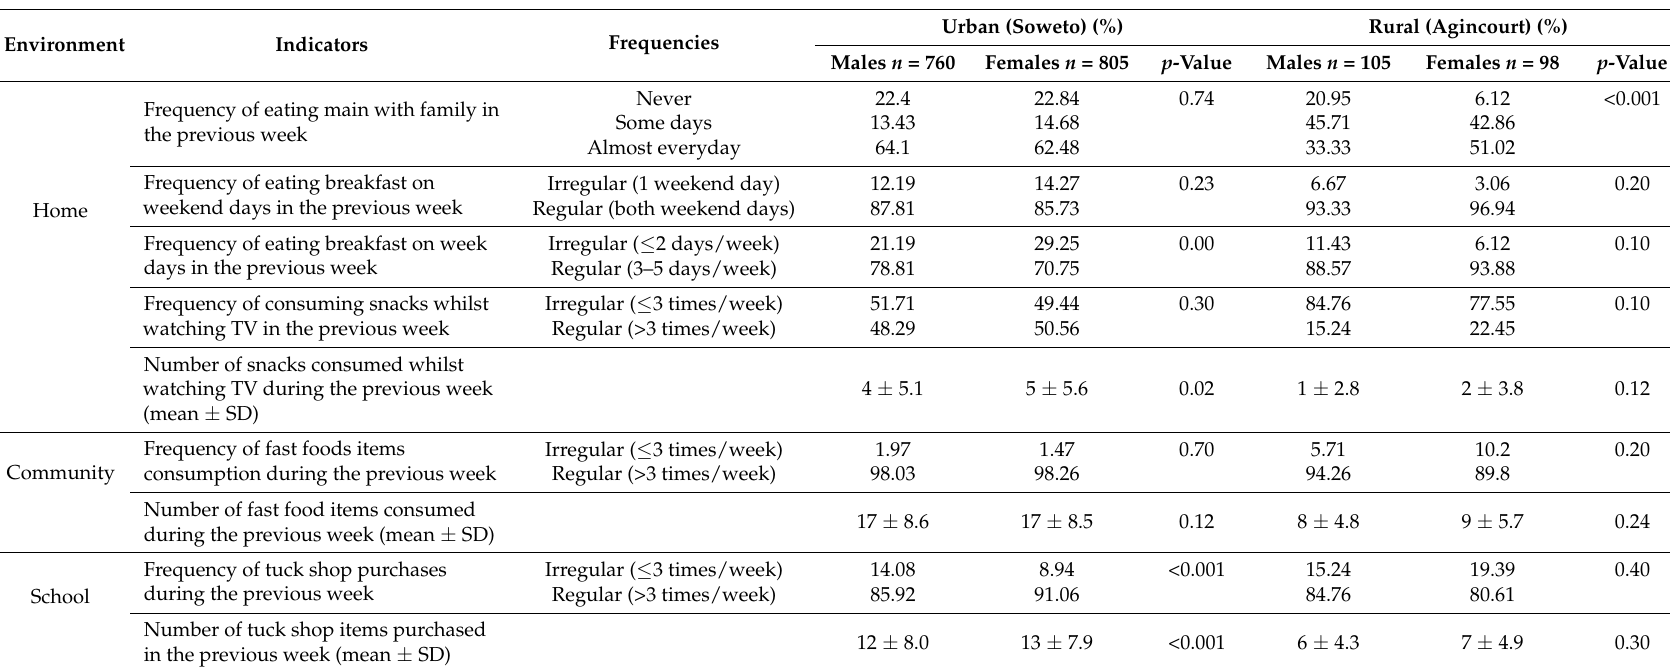
Table 2. Comparison of dietary practices and eating habits between genders within same site in the Y13/EA